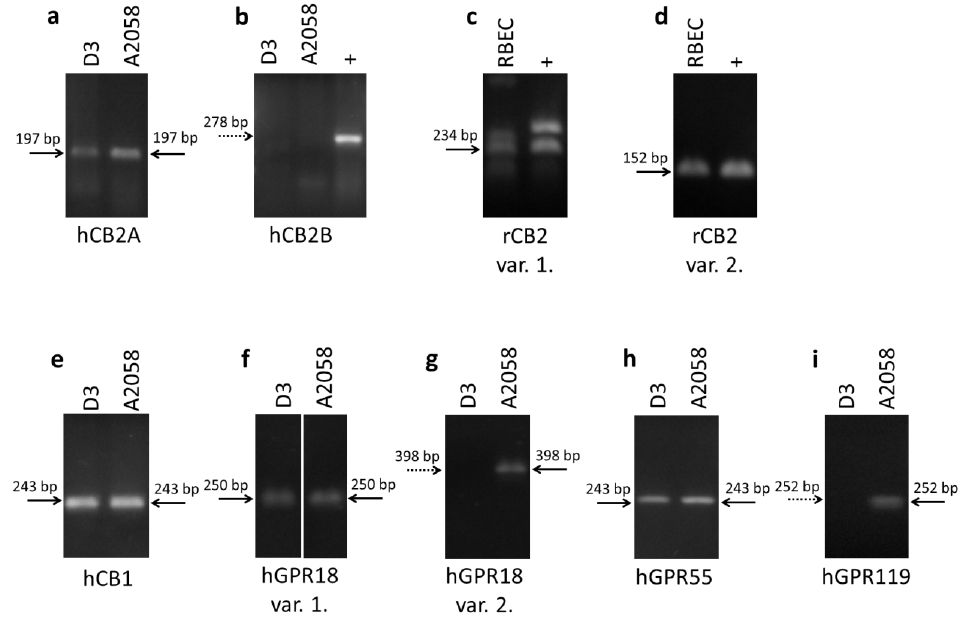
Figure 1. Expression of cannabinoid and cannabinoid-like receptors in brain endothelial and melanoma cells. RT-PCR was performed to determine the expression of CB2A and CB2B (positive control: HL-60) transcriptional variants of human CB2 receptor in hCMEC/D3 brain endothelial and A2058 melanoma cells ( a , b ); the expression of transcriptional variant 1 and 2 of rat CB2 receptor ( c , d ) in rat brain endothelial cells (RBECs) (positive control: rat spleen), the expression of CB1 receptor ( e ); transcriptional variant 1 and 2 of GPR18 ( f , g ); GPR119 ( h ) and GPR55 ( i ) in hCMEC/D3 human brain endothelial cells and A2058 melanoma cells. Dotted arrows indicate the absence of specific